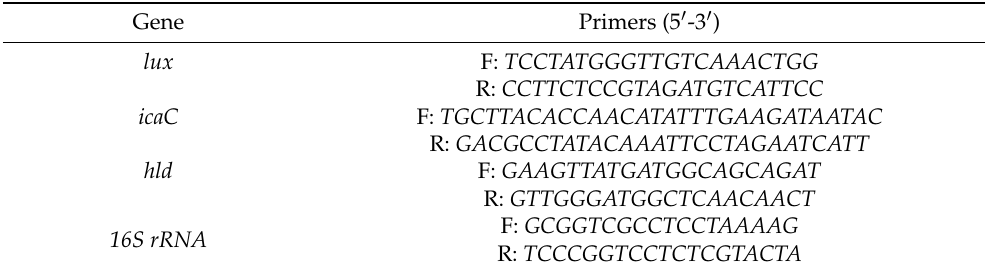
Table 2. Primers used in this